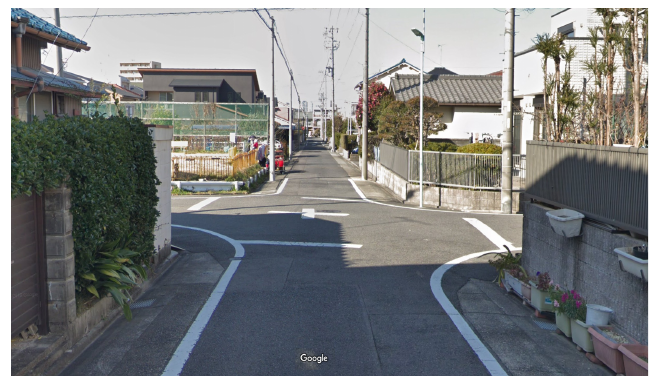
Figure 1. Example of a low-visibility intersection in a residential